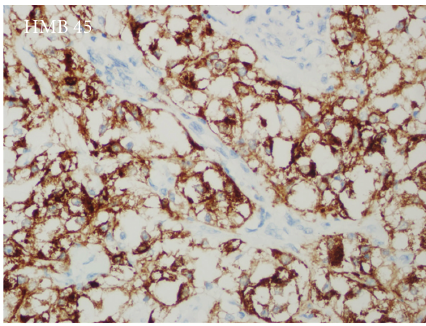
Figure 4: Cytoplasmic HMB45 positivity in perivascular tumor cells.